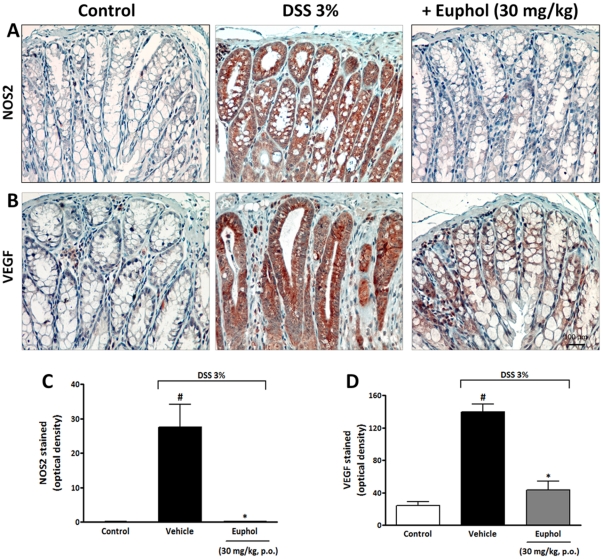
Euphol treatment inhibits NOS2 and VEGF expression in colonic tissue.After a 7-day euphol treatment, colon samples were processed for immunohistochemistry analysis. Preventive treatment with euphol (30 mg/kg, p.o.) significantly reduced NOS2 (A) and VEGF (B) immunostaining in the colon tissue after DSS-induced colitis in mice. Graphical representation of the immunostaining for NOS2 (C) and VEGF (D) expression evaluated in colon tissue. The mean intensity of NOS2 and VEGF staining were determined from image analysis and are represented as optical density. Scale bar corresponds to 100 µm and applies throughout. Each column represents the mean ± S.E.M. of 8 to 10 mice per group and is representative of three independent experiments. #P<0.05 vs. control healthy group (non colitic); *P<0.05 vs. DSS-treated group.